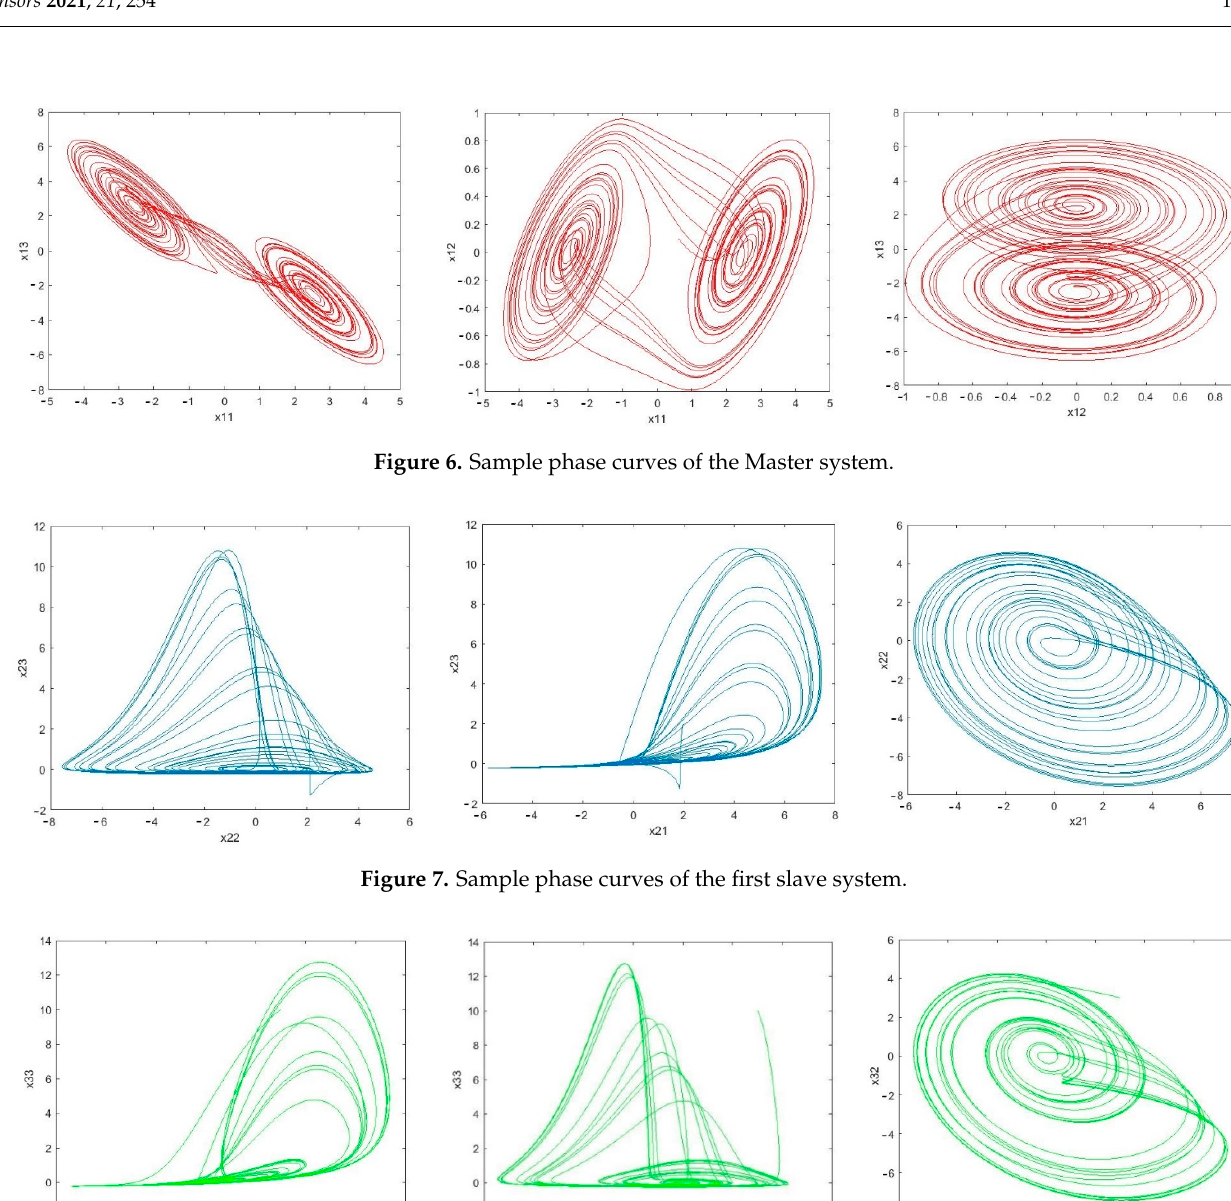
Figure 8. Sample phase curves of the second slave